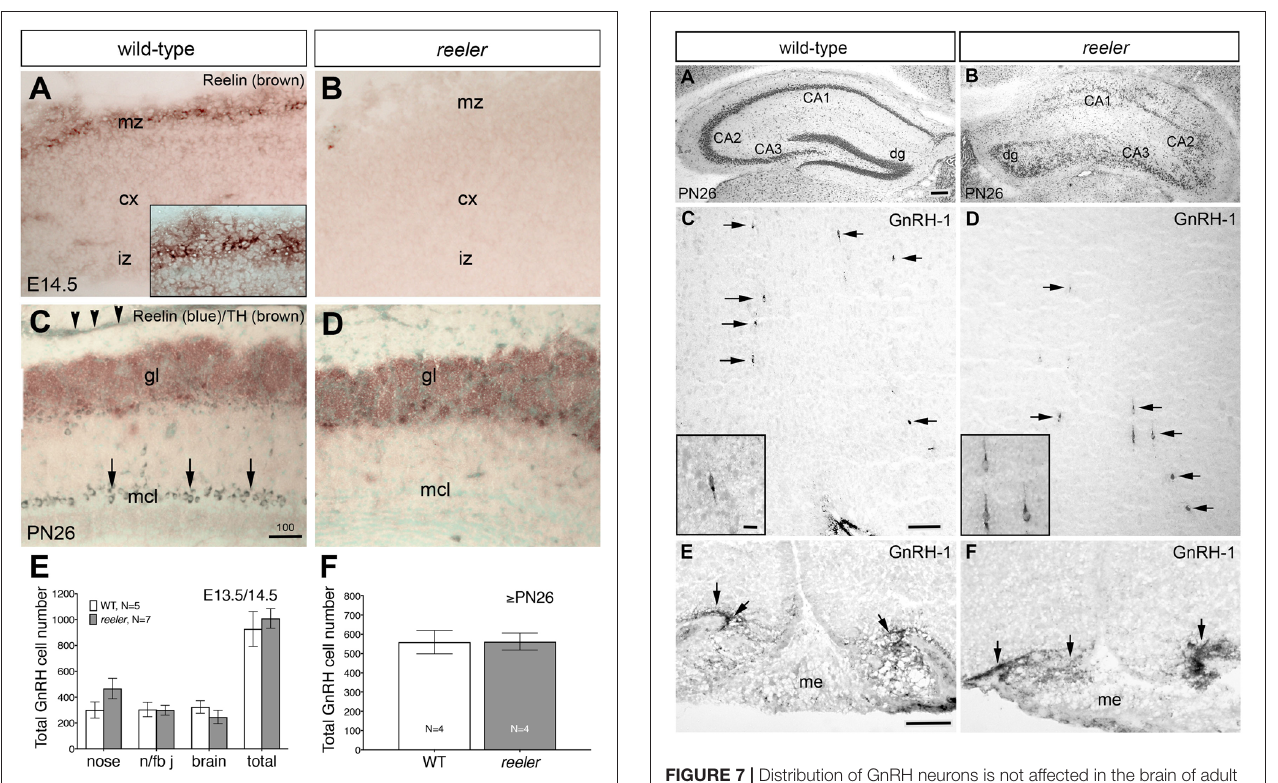
FIGURE 6 | GnRH neuronal migration is normal in reeler mice. (A–D) Sagittal sections of E13.5/14.5 and ≥ PN26 wildtype (WT) and reeler mice (B6C3Fe a/a-Reln/J) immunostained for indicated antibodies. (A,B) Cajal-Retzius cells are among the earliest neurons to be generated in the mammalian neocortex (cx) where they occupy positions near the pial surface, in the marginal zone (mz). In WT E14.5 mice these cells are Reelin-immunoreactive ( A , high power view shown in inset) whereas the cerebral cortex of reeler mice did not react with this antibody (B) , although Cajal-Retzius neurons are present (Derer, 1985; Ogawa et al., 1995). (C) Sagittal OB section of PN26 WT mouse immunostained for Reelin (blue) and tyrosine hydroxylase (TH; brown). Strong Reelin-immunoreactivity is detectable in the mitral cell layer (mcl; arrows) as well as in the olfactory nerve layer (arrowheads). TH-immunostaining identifies the glomerular layer (gl) of the OB. (D) In the OBs of reeler mice, Reelin is totally absent. (E) Analysis of GnRH neurons location at E13.5/E14.5 revealed no differences in the total number of cells or in the distribution of the GnRH-positive cells across their migratory route in WT and in reeler embryos. The areas of analysis for GnRH neuron location along the migratory pathway were the nasal compartment (nose), the nasal/forebrain junction (n/fb j) and the brain, respectively. (F) Quantitative analysis of GnRH neuronal population in ≥ PN26 brains revealed no differences in the Reelin mutants as compared to WT ( P > 0.1). Quantitative data are mean cell number ± SEM. Bar in (C) = 100 µ m (same in D ).